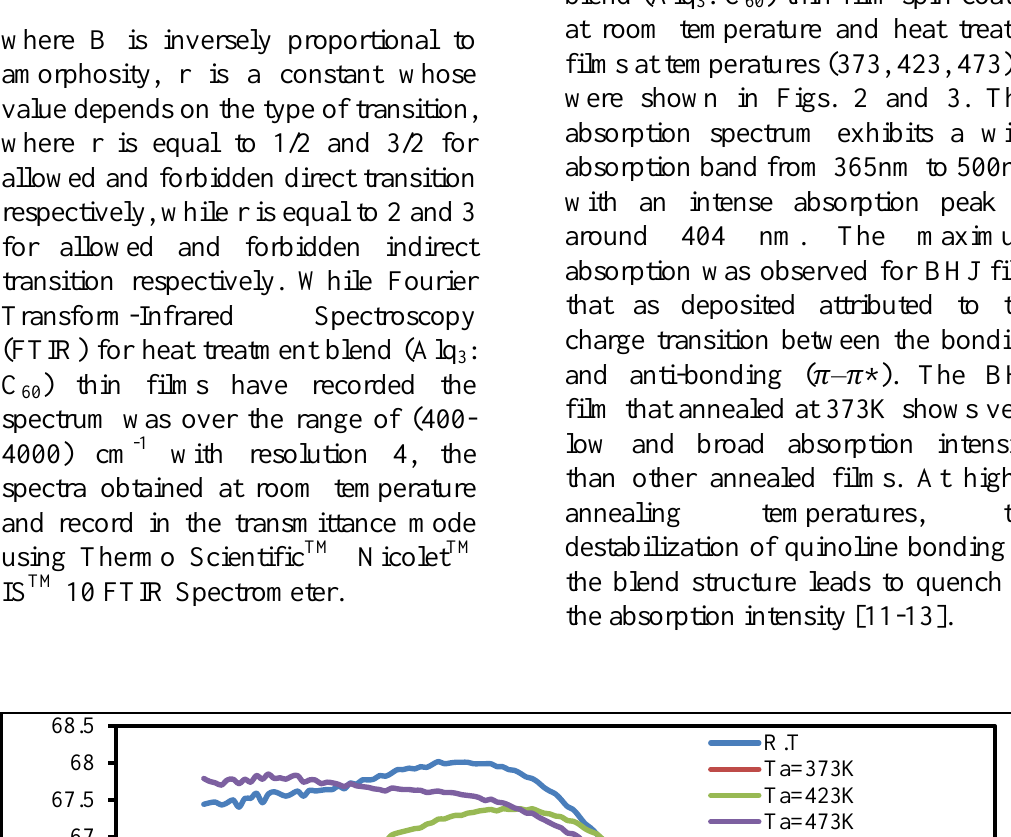
:C thin films (100:1) at 3 60